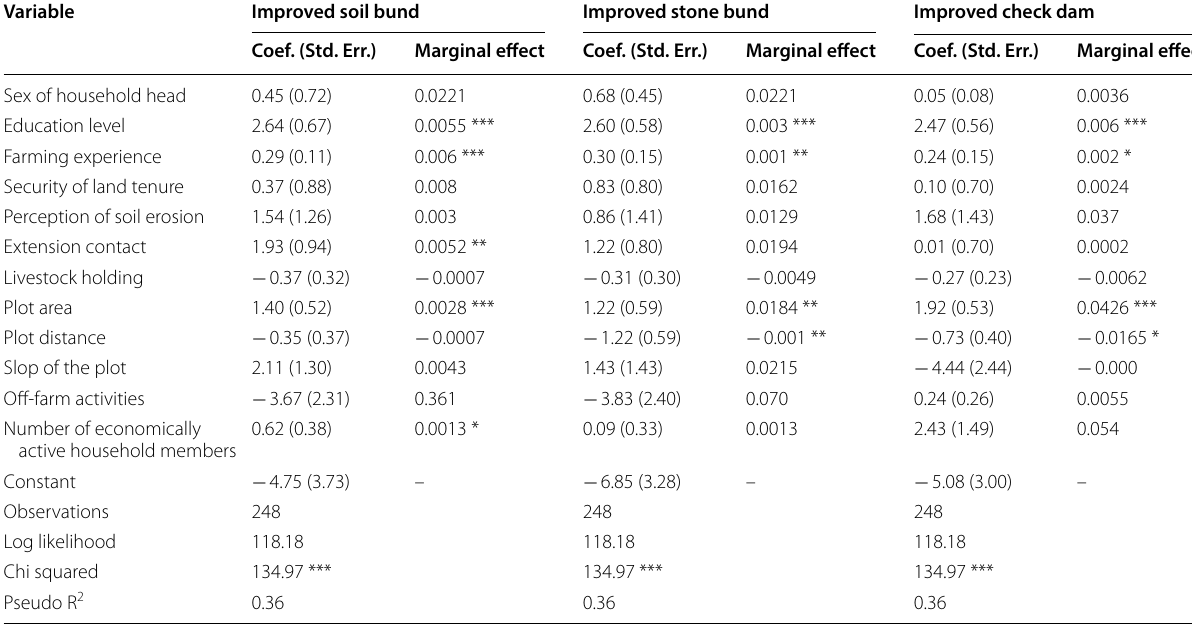
Dependent variable existence of improved structural SWC structure on the farm plot = *, **, *** significant at p < 0.1, p < 0.05, and p < 0.01 probability level, respectively